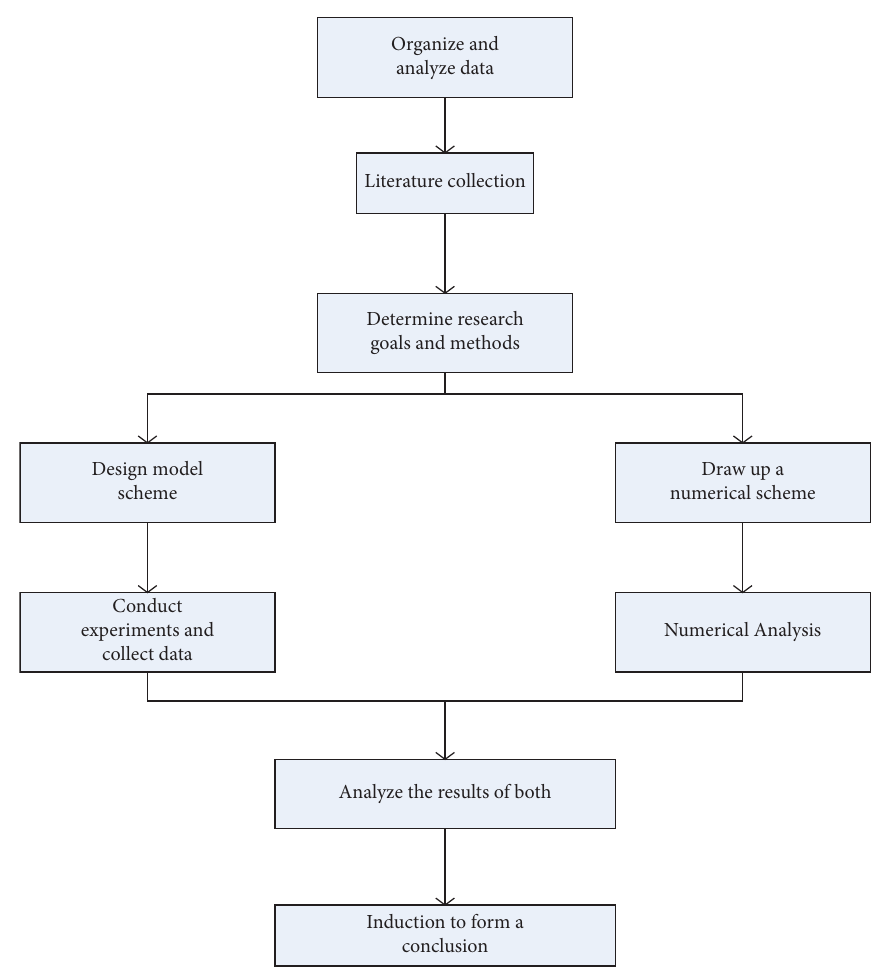
Figure 3: Main technical